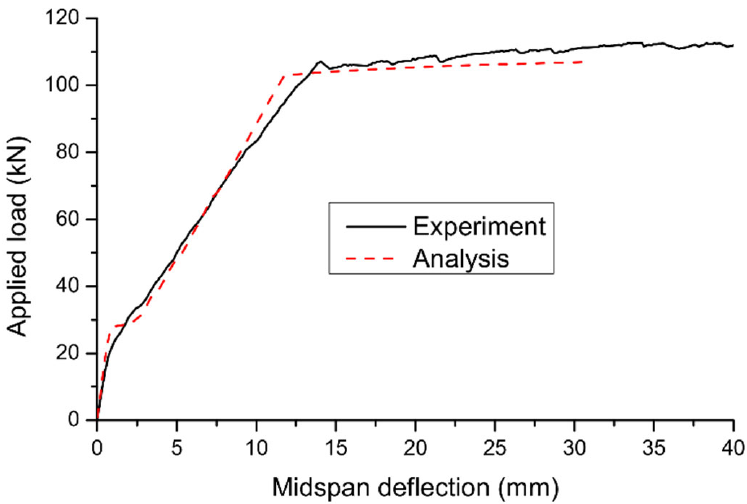
Figure 3. Comparison between predicted load-deflection curve and experimental data for B5.